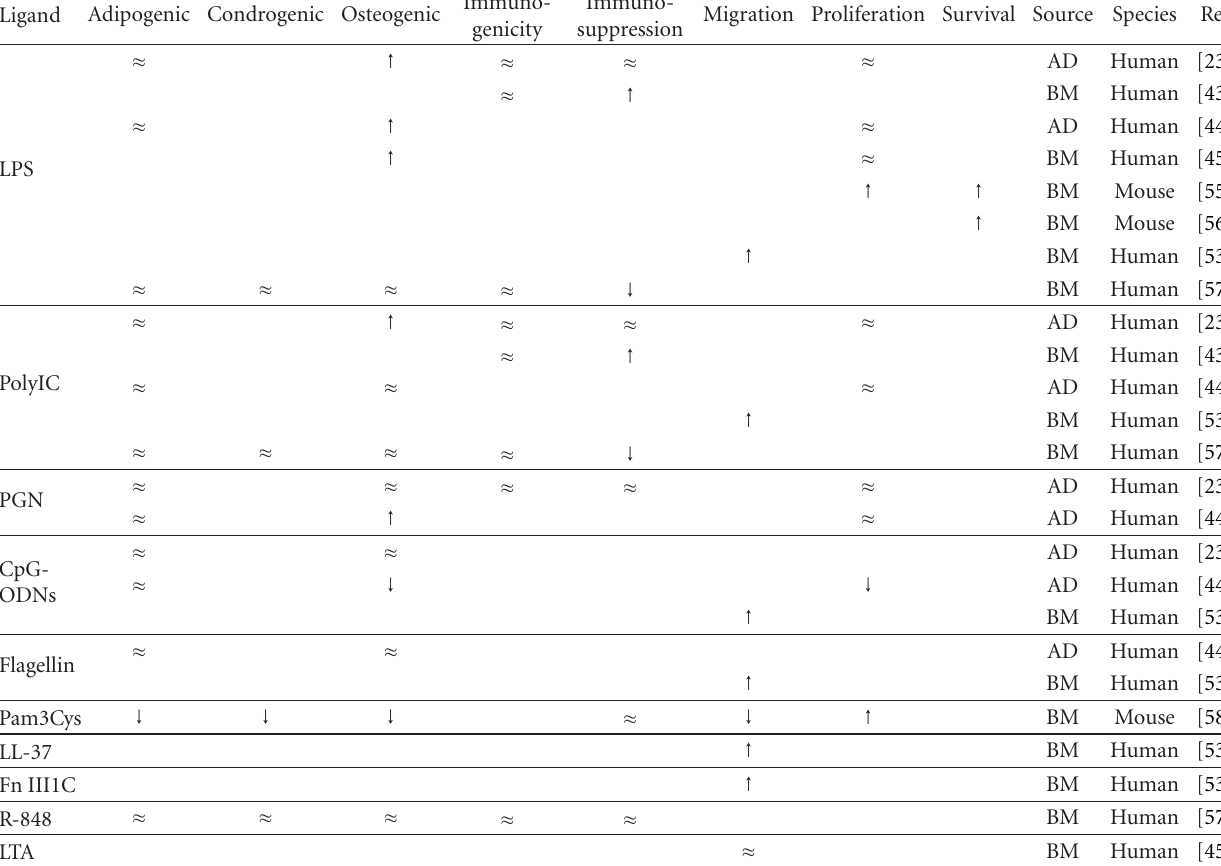
Table 1: Summary of reported e ff ects on MSC activity by TLR